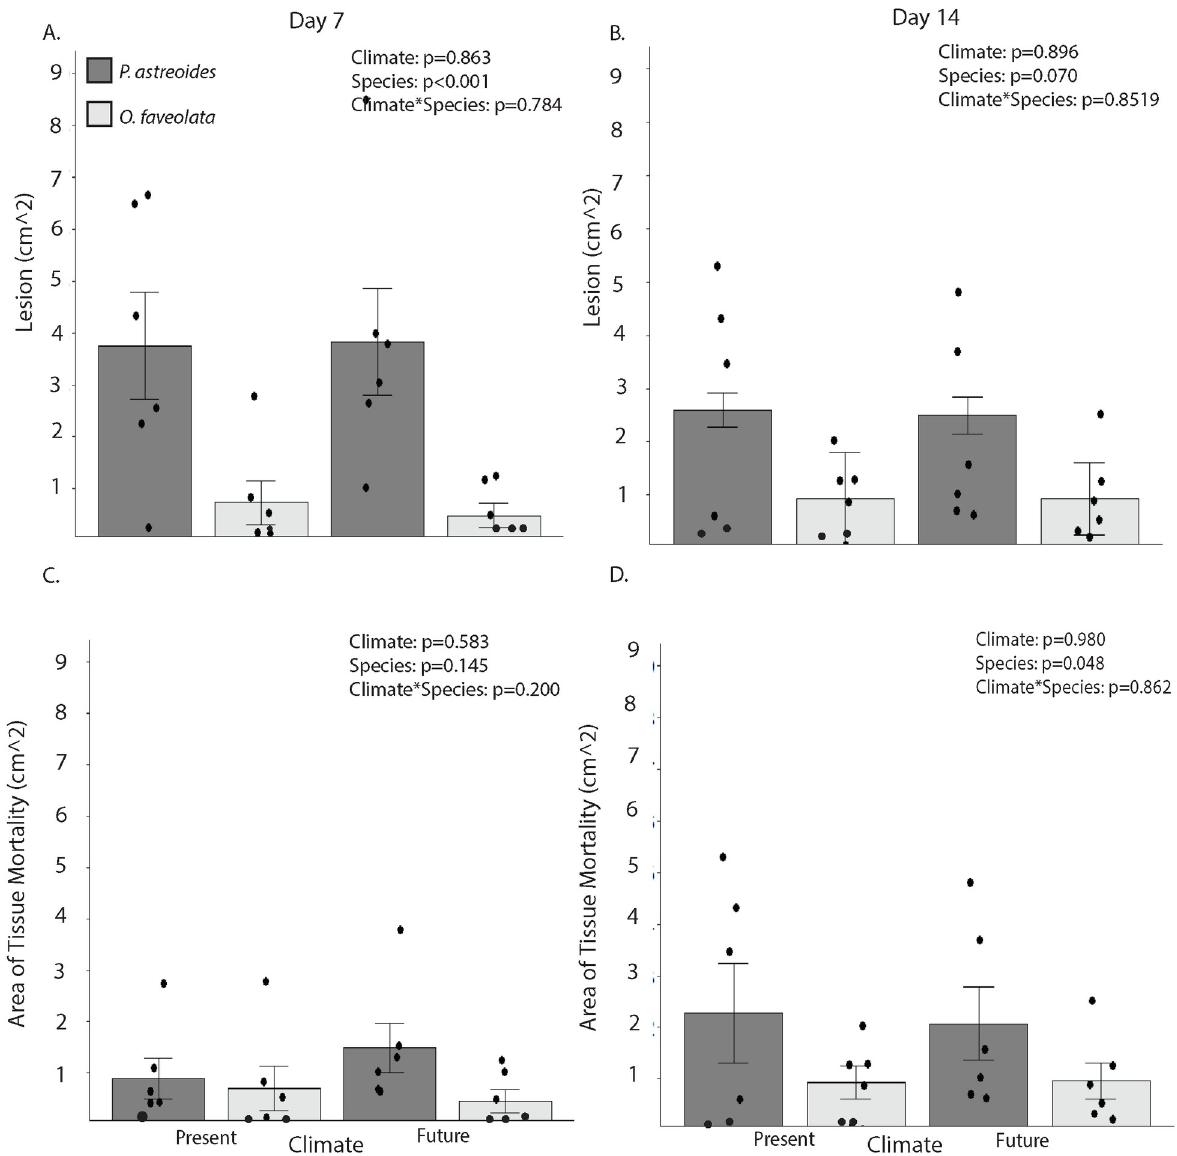
Fig 5. Lesion size and tissue mortality at Day 7 and Day 14. Lesion size (means ± SE) (A and B) and Area of Tissue mortality (means ± SE) (C and D) for each coral in contact with the other at day 7 (A and C) and day 14 (B and D). Lesion area is the area of each coral that exhibited discolored coral tissue plus the area where coral tissues have died and been lost. Area of tissue mortality corresponds to areas of bare skeleton with no living tissue. Analyzed with two-way Permutational ANOVA comparing species and climate. Dots represent individual data points. N = 6.